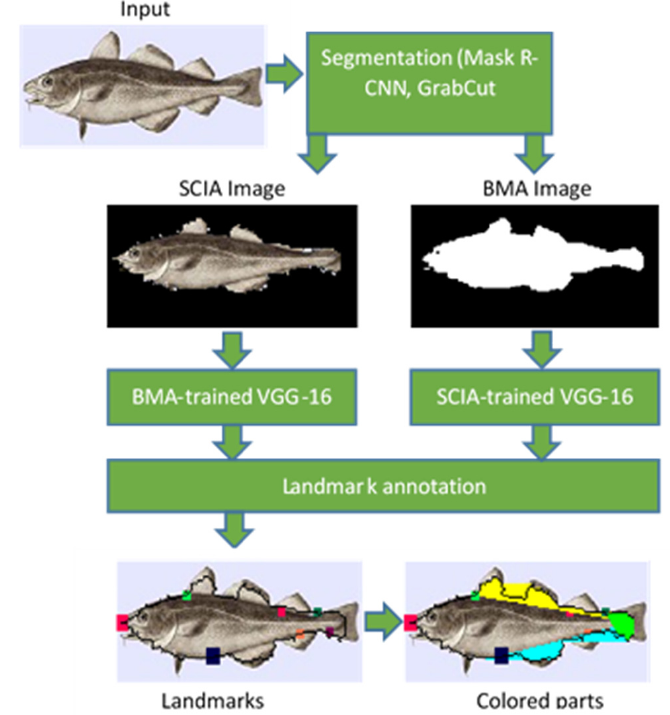
Figure 11. The BMA and SCIA deep learning approaches.